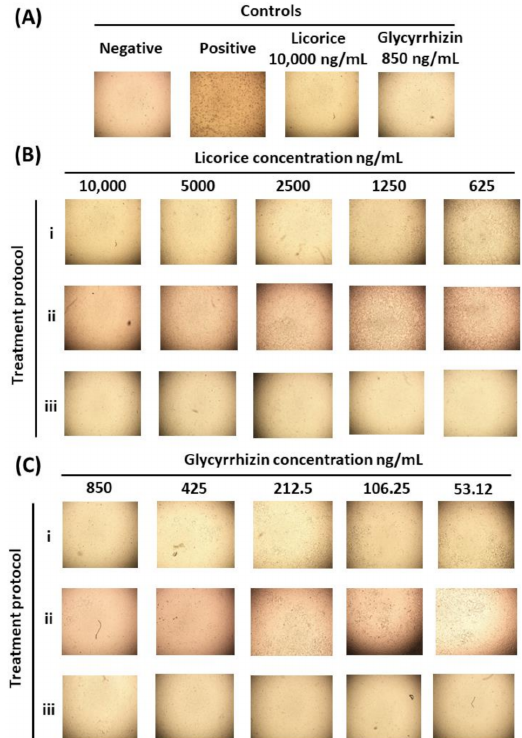
Figure 8. In vitro assessment of licorice and glycyrrhizin antiviral activity against SARS-CoV-2. Representative images of ( A ) controls: negative (uninfected cells), positive (infected cells), cytotoxicity controls (licorice- and glycyrrhizin-treated uninfected cells). ( B ) Antiviral effects of licorice at a range of concentrations on SARS-CoV-2 infected cells, and ( C ) antiviral effects of licorice at a range of concentrations on SARS-CoV-2 infected cells. Details about treatment protocols ( A – C ) are found in Section 3.5.4. (the effect of licorice and glycyrrhizin on viral induced cytopathic effect (CPE) and viral plaque forming efficiency